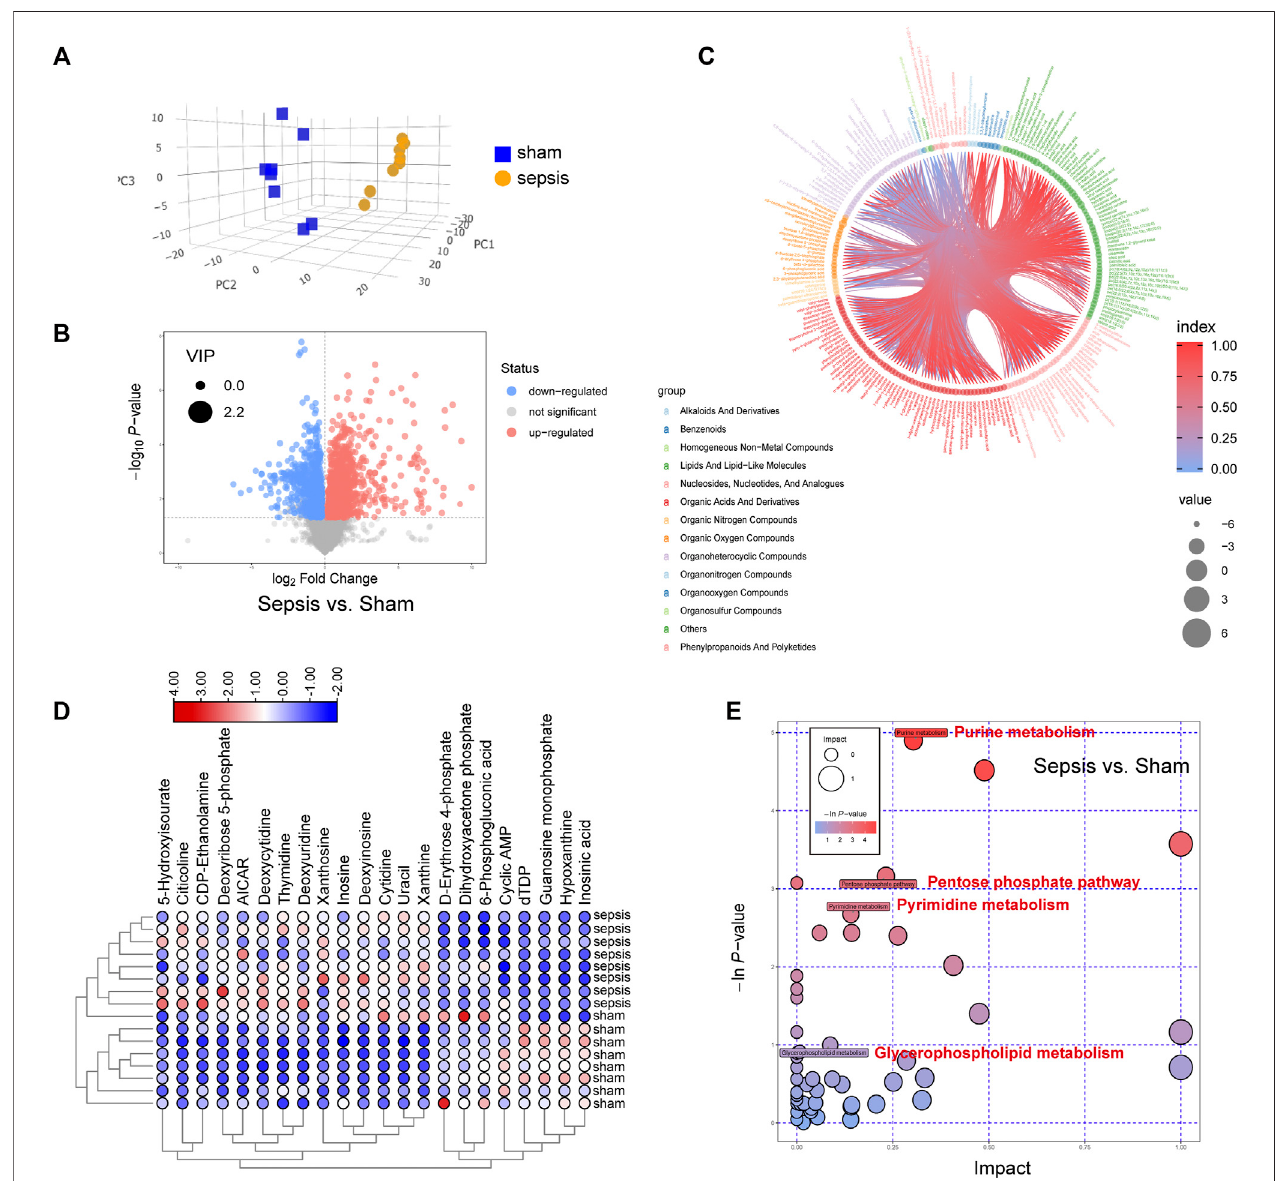
FIGURE3| Metabolicchangeswereidenti fi edbymetabolomicspro fi linginheartsofsepticratsandshamcontrols. (A) Principalcomponents analysis(PCA) score plot formetabolomicsanalysisinseptic ratsand normal control.Orangerepresentssepsisrats, andblue representsnormalcontrol. (B) Volcano plot, (C) circle diagram, and (D) heatmap analyzed by TBtools showing the signi fi cantly changed metabolites in septic rats and normal control. (E) Bubble plot of the metabolic pathway enrichment analysis identi fi ed in septic rats and normal control. The different color depths of circles represent the p -value of pathway enrichment analysis.